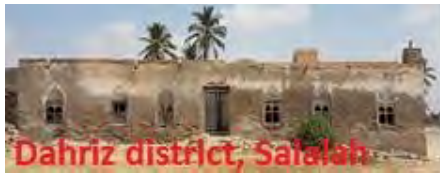
Figure 4. Fac¸ade’s photograph building location